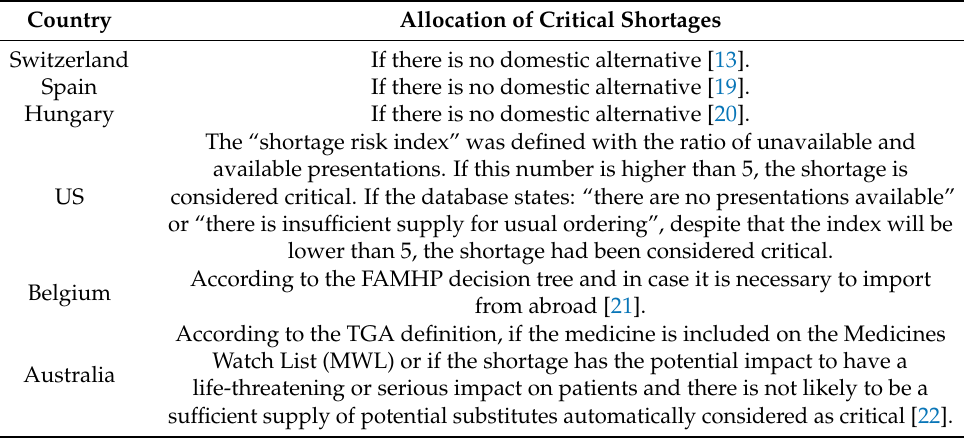
Table 1. Allocation of critical shortages. Country Allocation of Critical